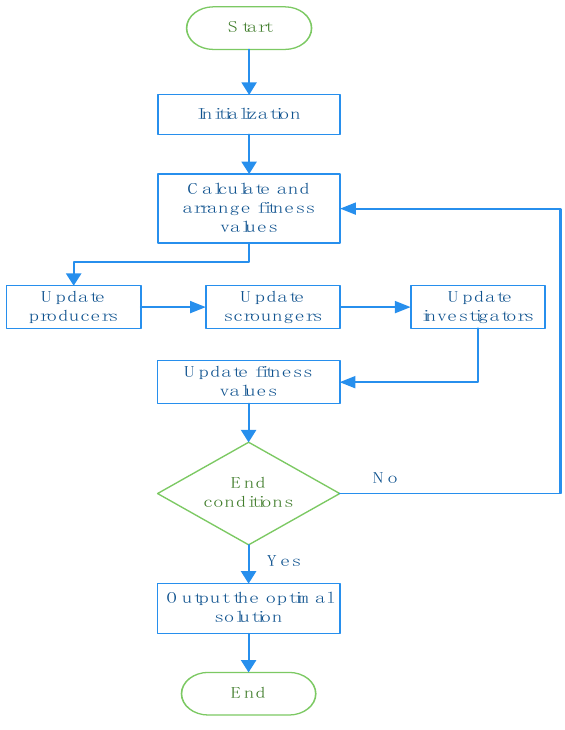
Figure 1. Flow chart of SSA.